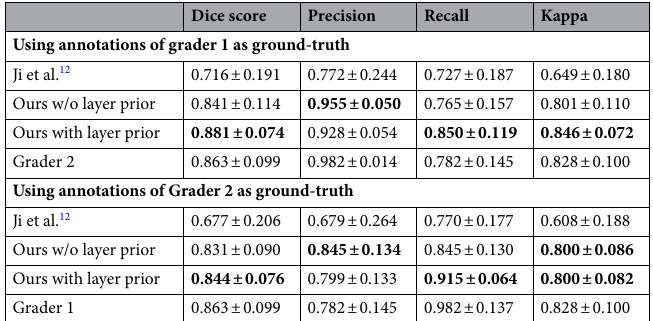
Dice score Precision Recall